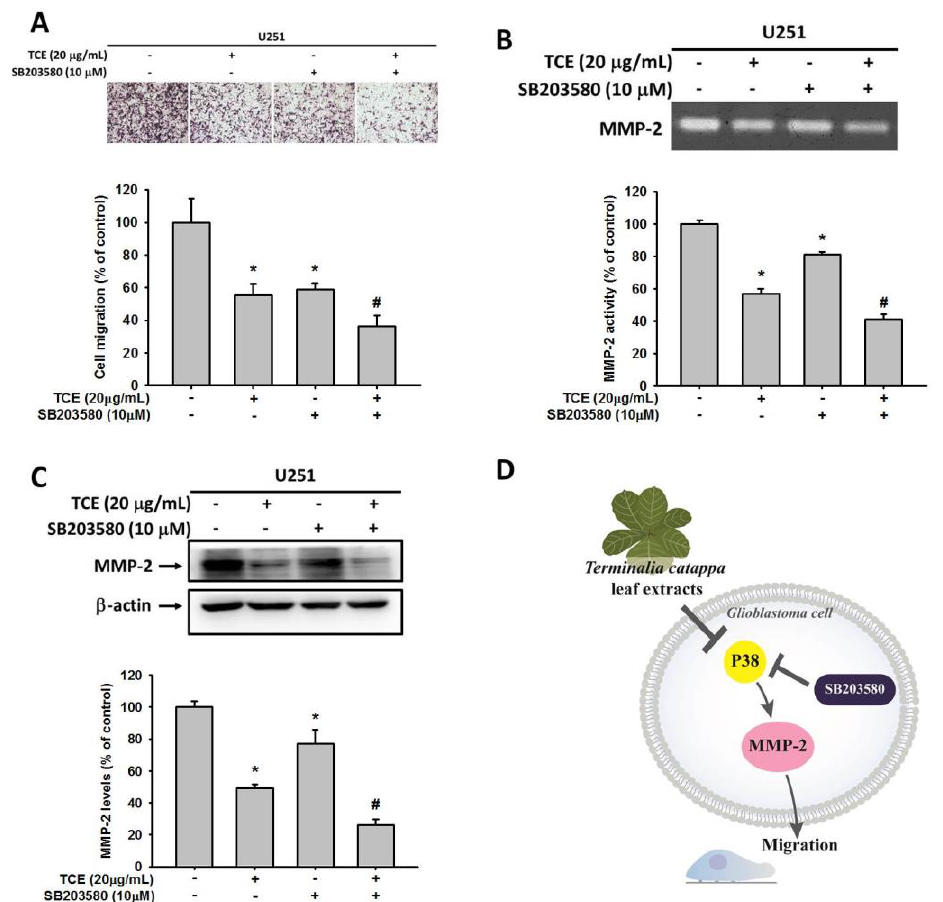
Figure 5. Effects of T. catappa L. extract (TCE) and p38 inhibitor (SB203580) on MMP-2 activity, protein expression and migration of U251 cells. U251 cells were treated with SB203580 combined with or without 20 μg/mL of TCE for 24 h. Analysis of ( A ) the migration of U251 cells was assessed as described in the Methods Section. A gelatin zymography assay was used for measurement of MMP-2 activity ( B ) and protein expression ( C ). ( D ) Schematic illustrates the mechanisms by which TCE inhibits GBM cell migration through the p38 pathway. * p < 0.05, compared with the vehicle group. # p < 0.05, compared with the TCE-treated group.